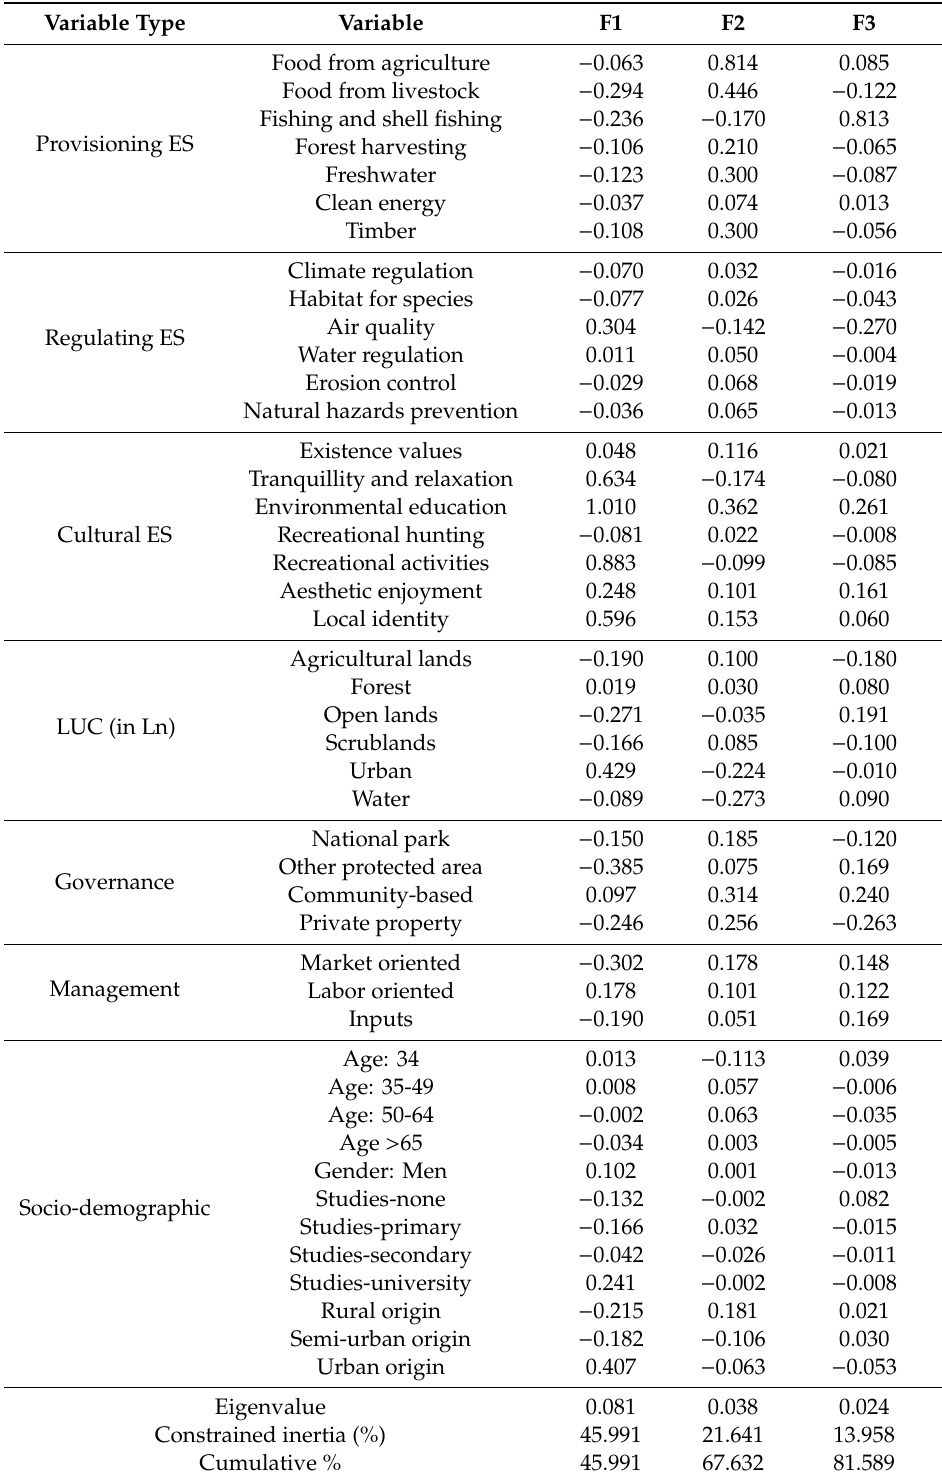
Table A1. Redundancy analysis scores for the first three factors obtained for ES and two dependent variables and biophysical characteristics (land use covers: LUC), sociodemographic characteristics and institutional context (based on governance and management models) as explanatory